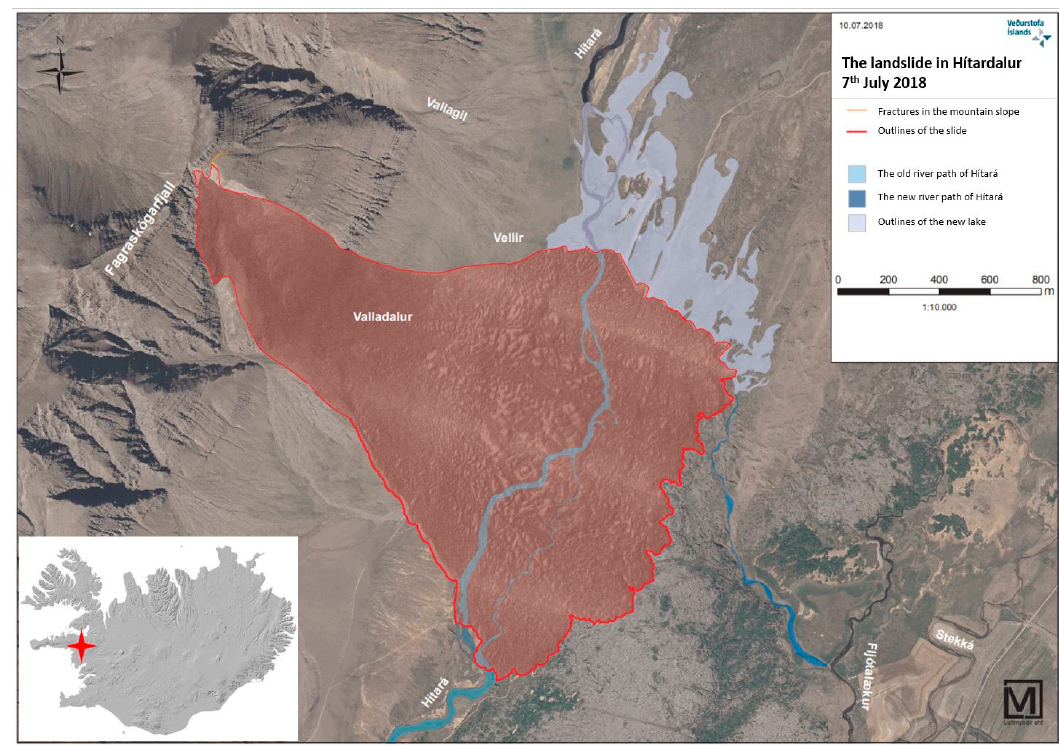
Figure 8. The Hítardalur landslide on the 7 July 2018 (modified from vedur.is, 2018). Figure 8. The H í tardalur landslide on the 7 July 2018 (modified from vedur.is, 2018). As the slide flowed down to the valley floor and dammed up the H í tar á and formed a new lake. As H í tar á is a salmon fishing river, this had economic consequences.